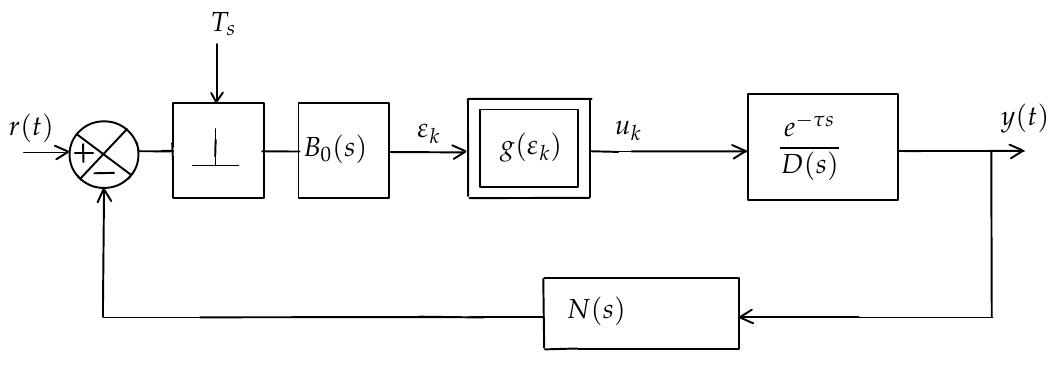
Figure 1. Block representation of the studied system